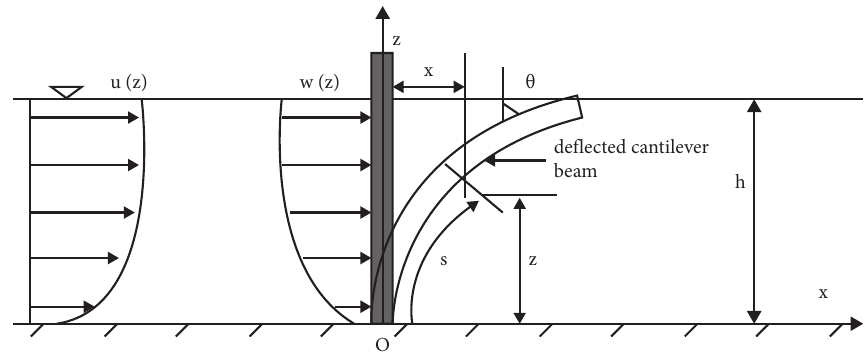
Figure 1: Schematic diagram of cantilever